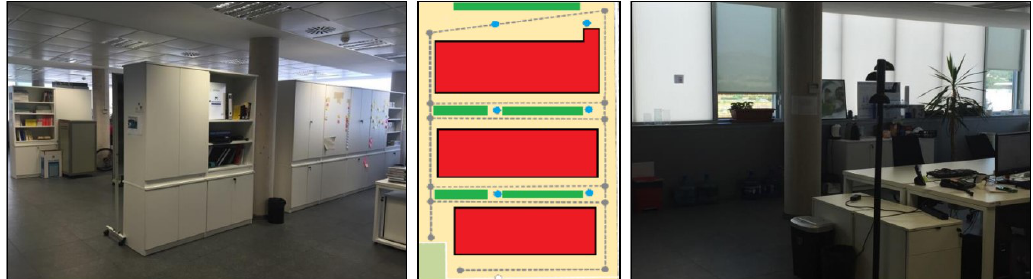
Figure 18. Data collection environment for UJIIndoorLoc-Mag. The Center figure shows the path trajectory used for the data collection. The red area shows the desktop computer tables while the dotted lines indicate the data collection path. Circles indicate the starting and ending points for each data collection path